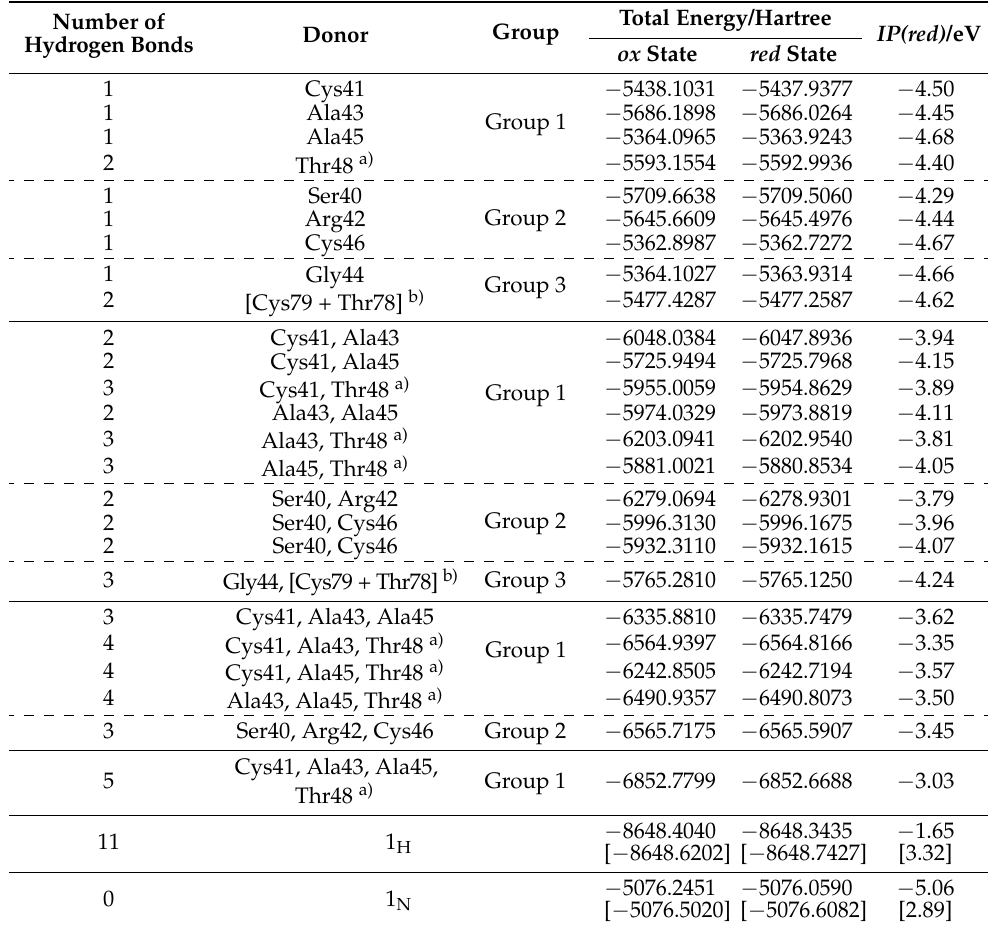
Table 5. Calculated total energies of the ox and red states and the IP(red ) values of the amino acid models. The result under the solvent (water) effect for 1 H and 1 N is written in square